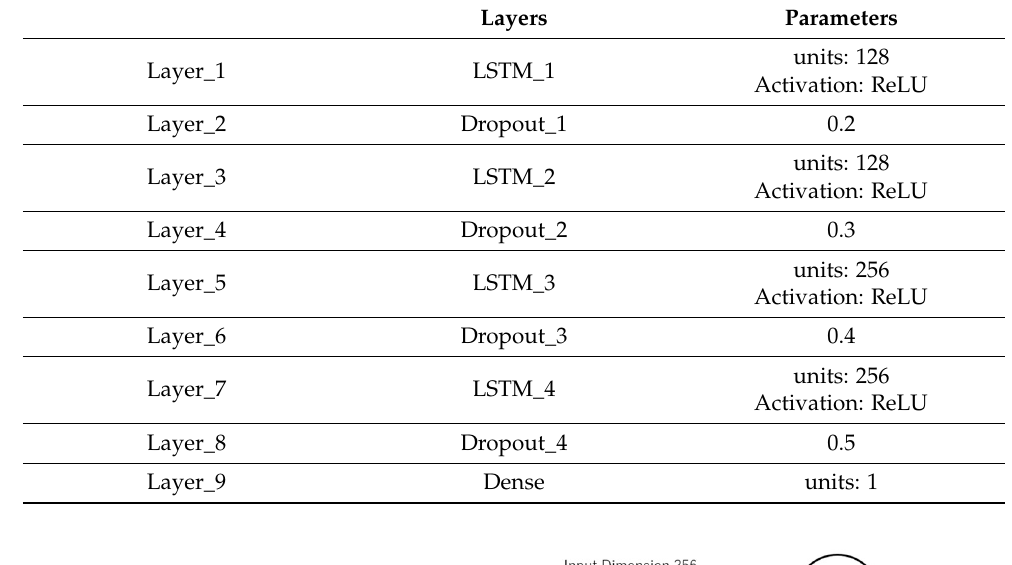
Table 1. Details of the LSTM model.